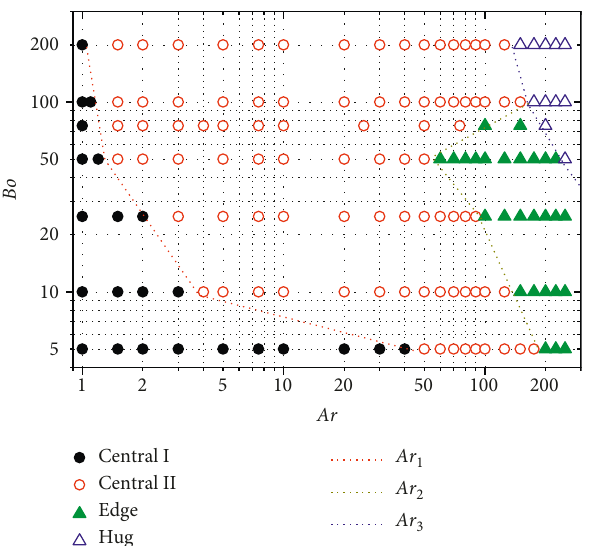
Figure 8: Ar-Bo map of coalescence regimes plotted as Bo versus Ar.